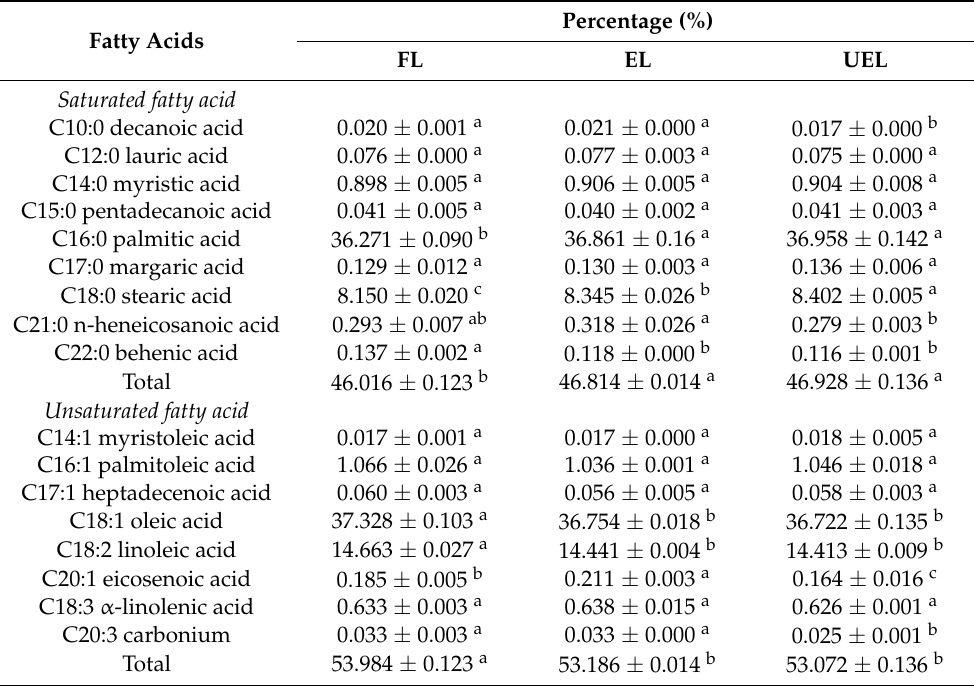
Table 1. GC results of fatty acid compositions in FL, EL, and